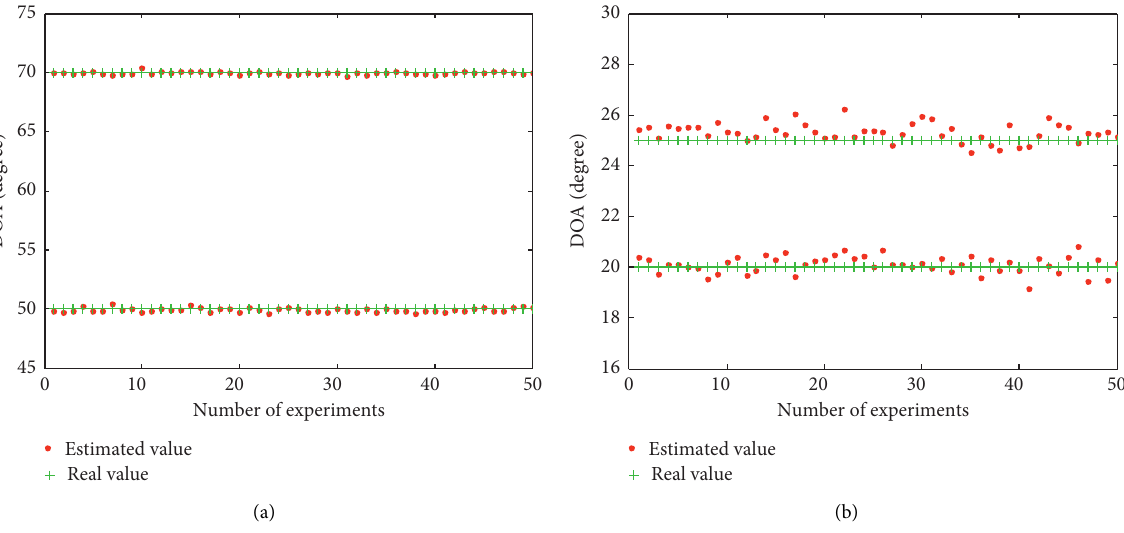
Figure 7: The DOA estimation versus the number of experiments.